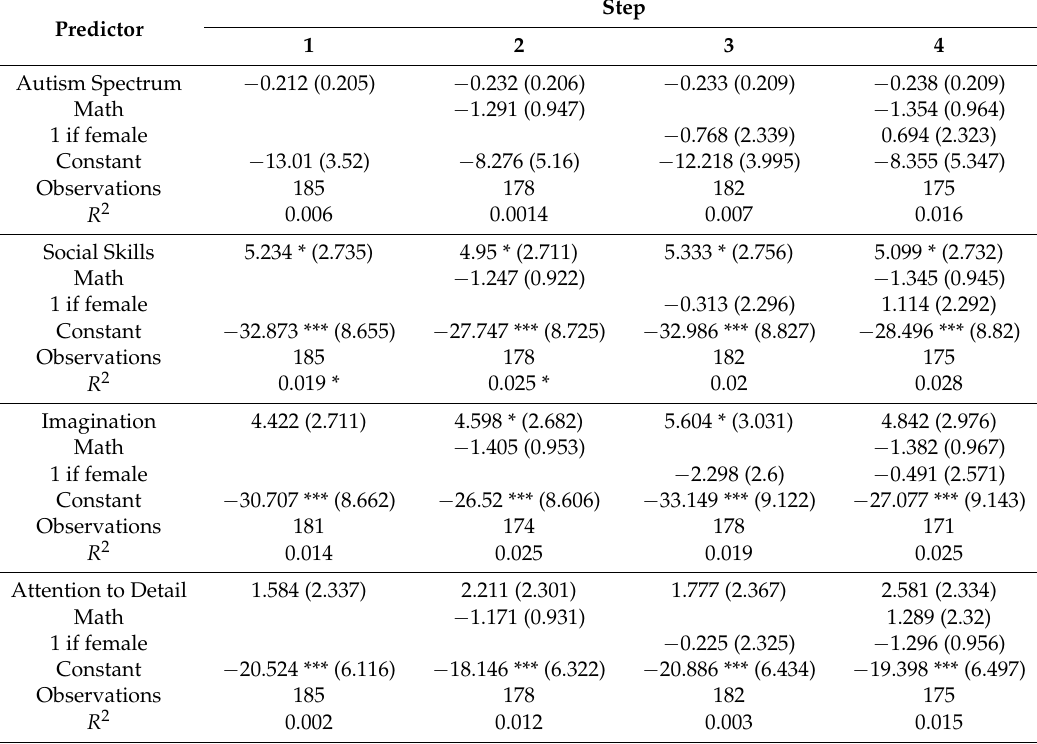
Table 3. Estimates of individual regression models predicting strategic IQ controlling for math skill and